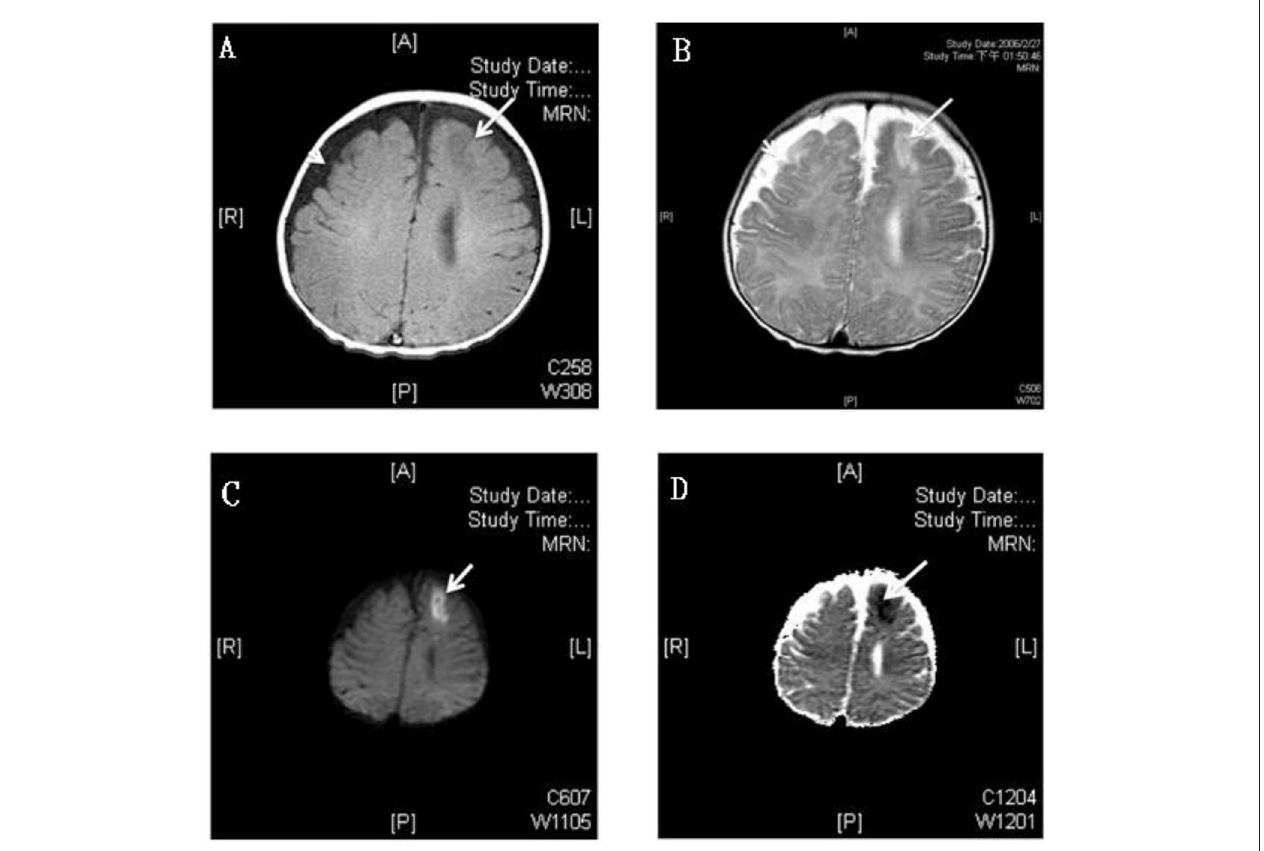
FIGURE 3 | MRI study of a 3 month old boy with GBS meningitis and infarction. (A) Axial T1-weighted gadolinium-enhanced MRI showed hyperintensity and (B) T2-weighted MRI showed hypointensity over left anterior frontal area (white arrows) and bilateral frontotemporal subdural effusion (white arrow head); The left anterior frontal lesion showed hyperintensity over diffusion-weighted (C) and hypointensity over apparent diffusion coefficient (D) weighted MRI which revealed recent infarction (white